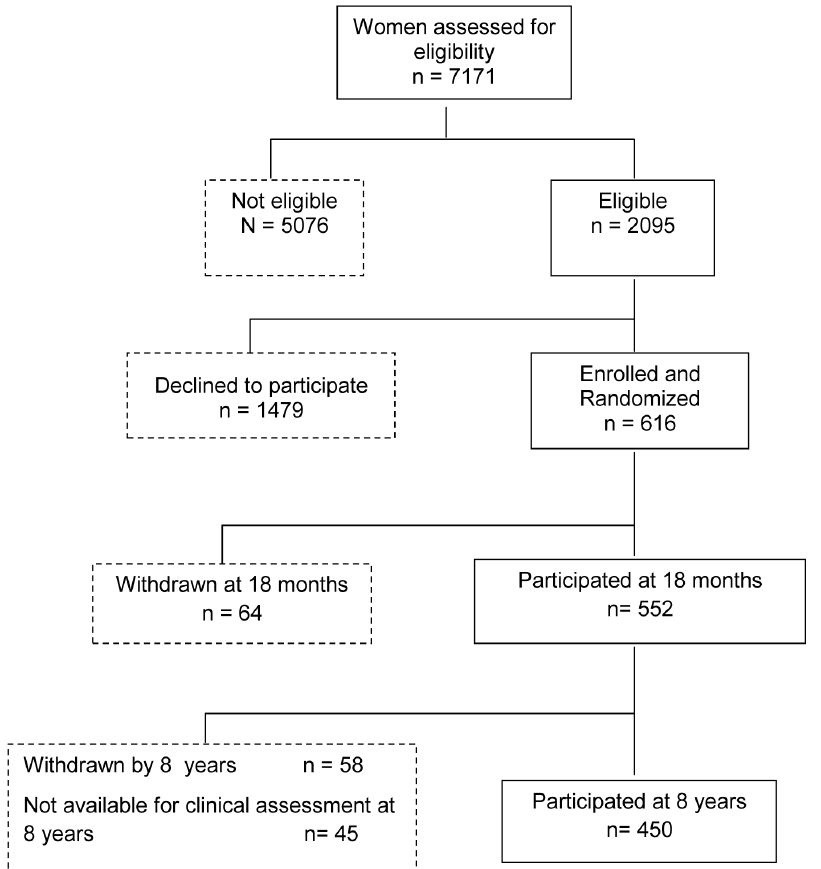
Figure 1. Flow chart displaying the participation in CAPS from birth to 8 years. Recruitment, entry and retention through 8 years of follow- up in the Childhood Asthma Prevention Study (CAPS) Trial.